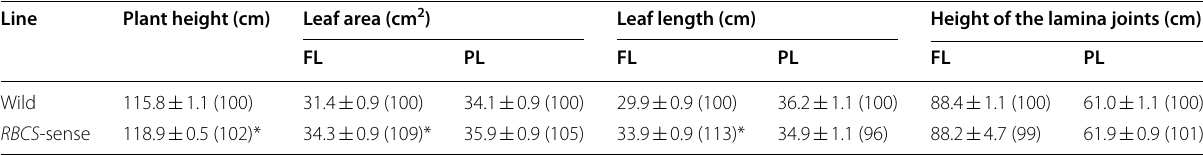
Data represent means the standard error (plant height: n 26 in the wild-type and n 20 in the RBCS -sense, leaf area of flag leaves: n ± = = RBCS -sense, leaf area of the penultimate leaf blades: n 51 in the wild-type and n 49 in RBCS -sense, length of flag leaf: n = = RBCS -sense, leaf length of the penultimate leaf blades: n 20 in the wild-type and n 23 in the RBCS -sense, height of lamina joints: n = = the RBCS -sense). * p < 0.05 between the wild-type and RBCS -sense rice plants using Student’s t- test. Values in parentheses indicate the percentage of the values of wild-type rice plants. The abbreviations stand as follows: “DAH”; days after heading, “FL”; flag leaves, “PL”; penultimate leaf blades, “ RBCS -sense”; transgenic rice plants overproducing Rubisco, “Wild,”; wild-type rice